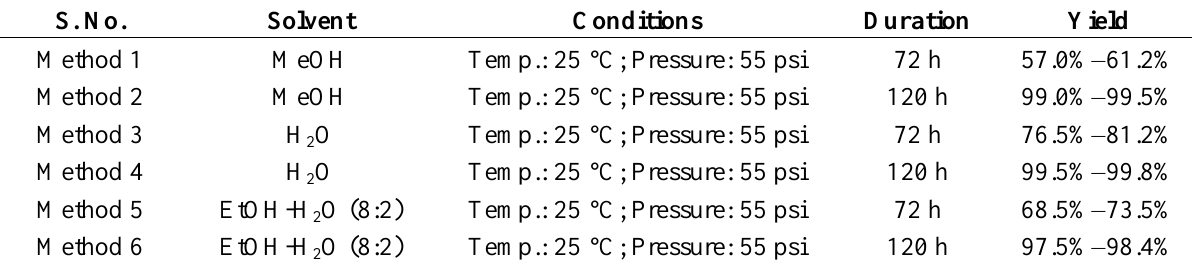
Table 4. Catalytic hydrogenation of Rebaudioside A ( 1 ); Rebaudioside B ( 2 ); Rebaudioside C ( 3 ); and Rebaudioside D ( 4 ) using Raney Ni and yields of various